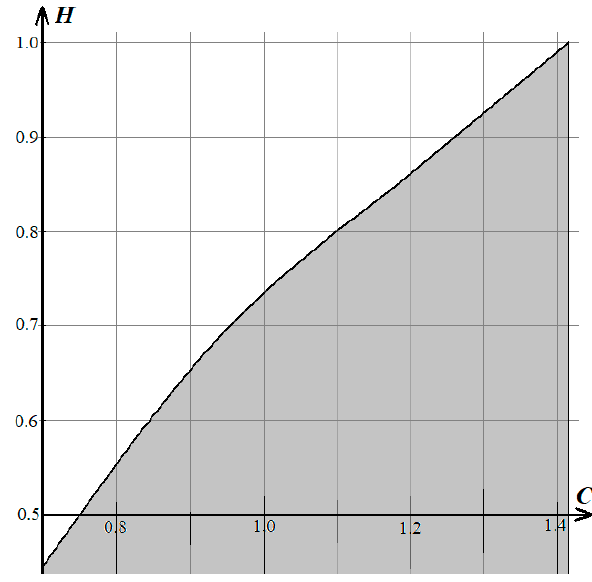
Figure 7. The region of existing of traveling wave solutions—shadow zone. Zones of permissible wave steepness versus wavelength are shown in Figure 8 for the FN and BM models. The shadow zone ( I ) corresponds to the model BM, and the shadow zones ( I ) plus ( II ) correspond to a fully nonlinear model (FN). As can be seen, the admissible regions for the two models are fundamentally different for moderate wavelengths. The BM model appears to express unrealistically low steepness values for moderate wavelengths.